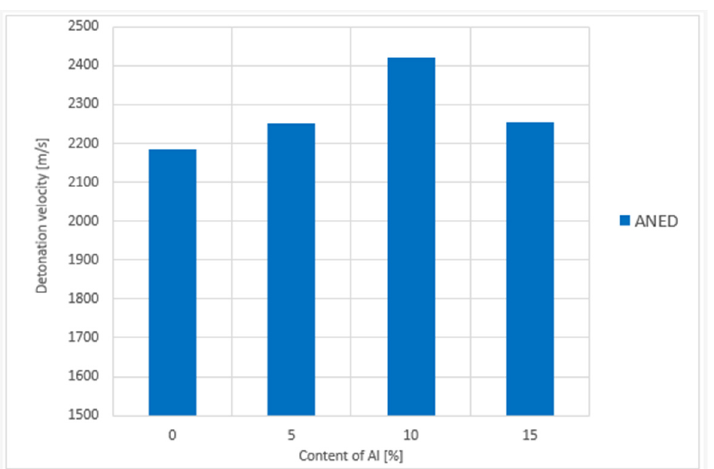
Figure 6. The dependence of the detonation velocity of AN mixtures with alcohols on the carbon chain length in a molecule.